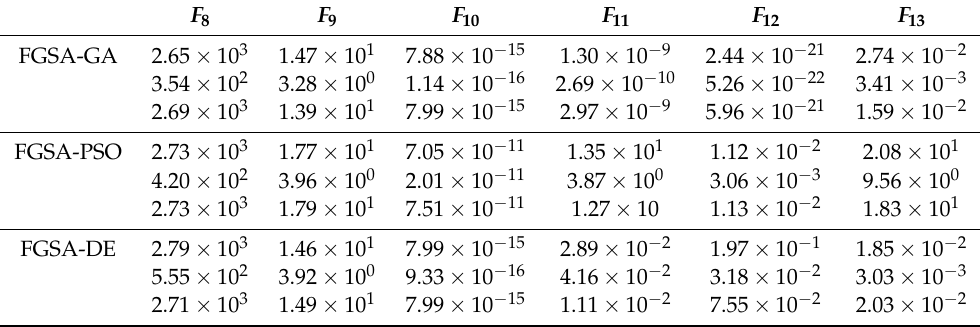
Table 4. Comparisons between FGSA-GA, FGSA-PSO and FGSA-DE over 30 runs for multimodal